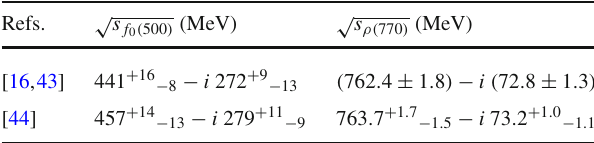
Table 5 f 0 ( 500 ) and ρ( 770 ) resonance poles obtained in [16,43,44] using Roy equations